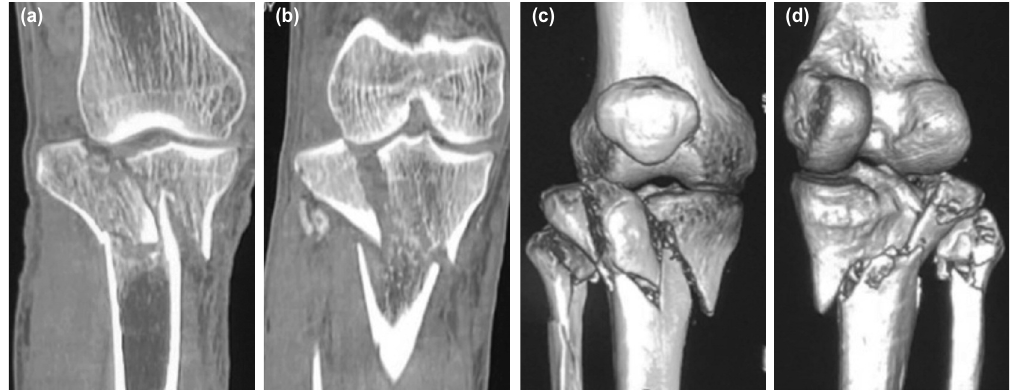
Case No.12, pre-operative CT images. (a) Coronal section image showing Shatzker Type VI fracture. (b) Coronal section image Fig. 3: showing tibial condylar widening and intra-articular step. (c) 3D reconstruction view anterior aspect. (d) 3D reconstruction view posterior aspect.